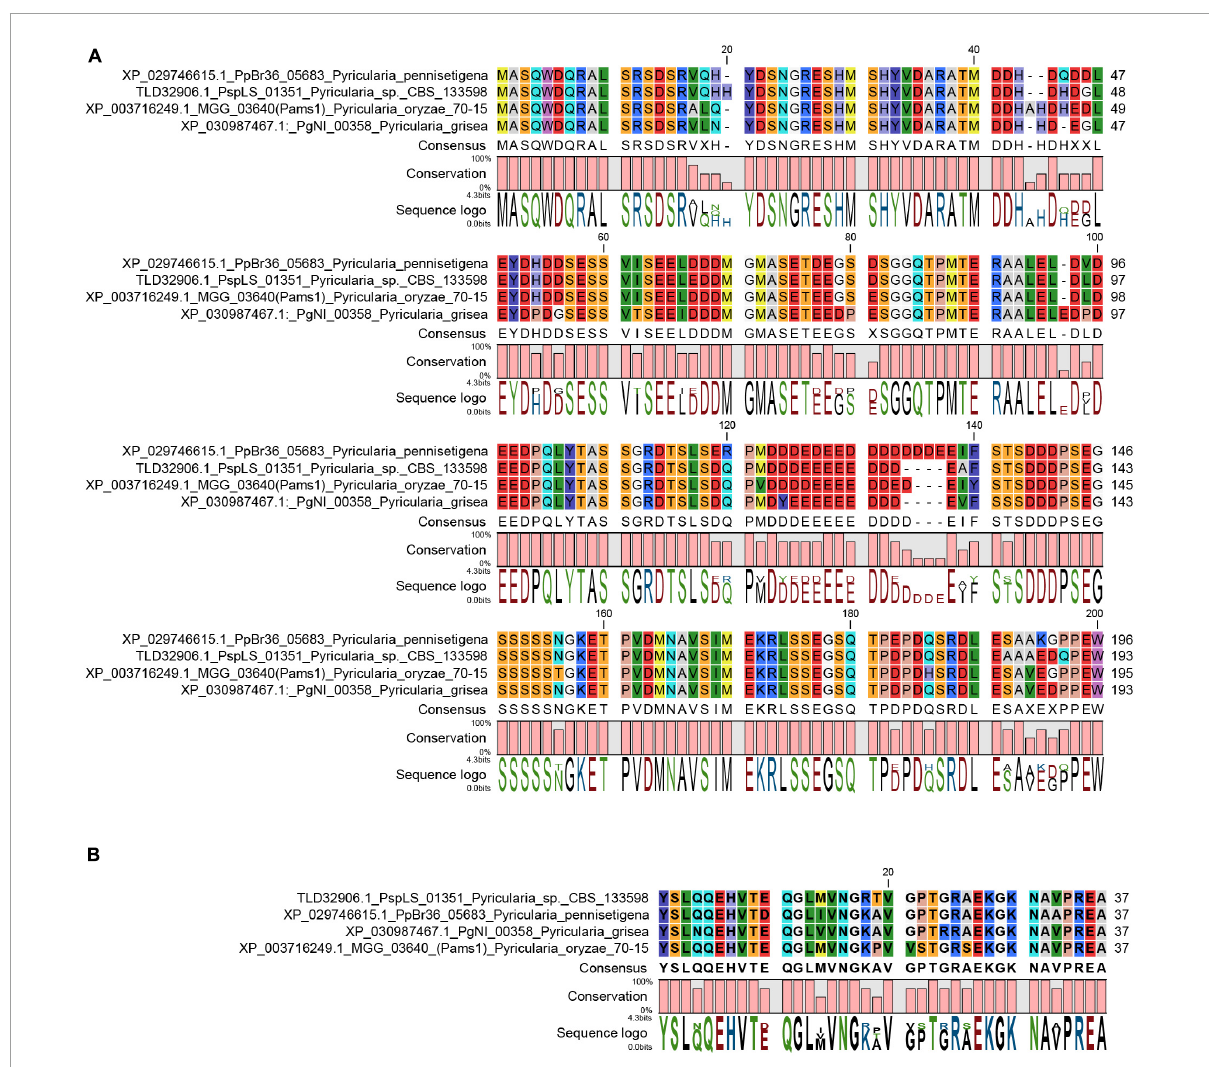
FIGURE3 N-terminal and C-terminal peptide sequences of Pams1 were only present in Magnaporthe species. (A,B) Alignment of Pams1-N (A) and Pams1-C (B) homologs ( E -value < 1.0) by BLAST search using the respective Pams1-N (1–195 aa) or Pams1-C (691–727 aa) peptide sequences in